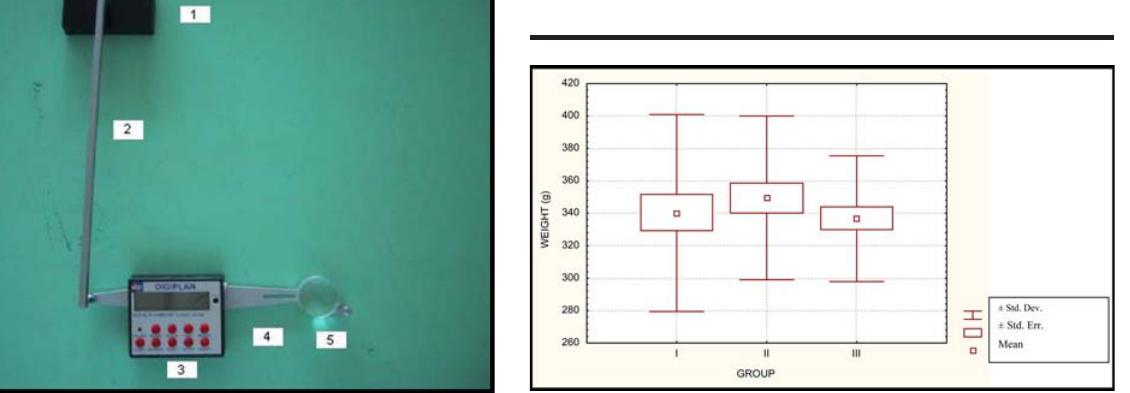
FIGURE 7 - A planimeter adjusted to calculate photo areas. 1. weight; 2. long arm; 3. control; 4. short arm;